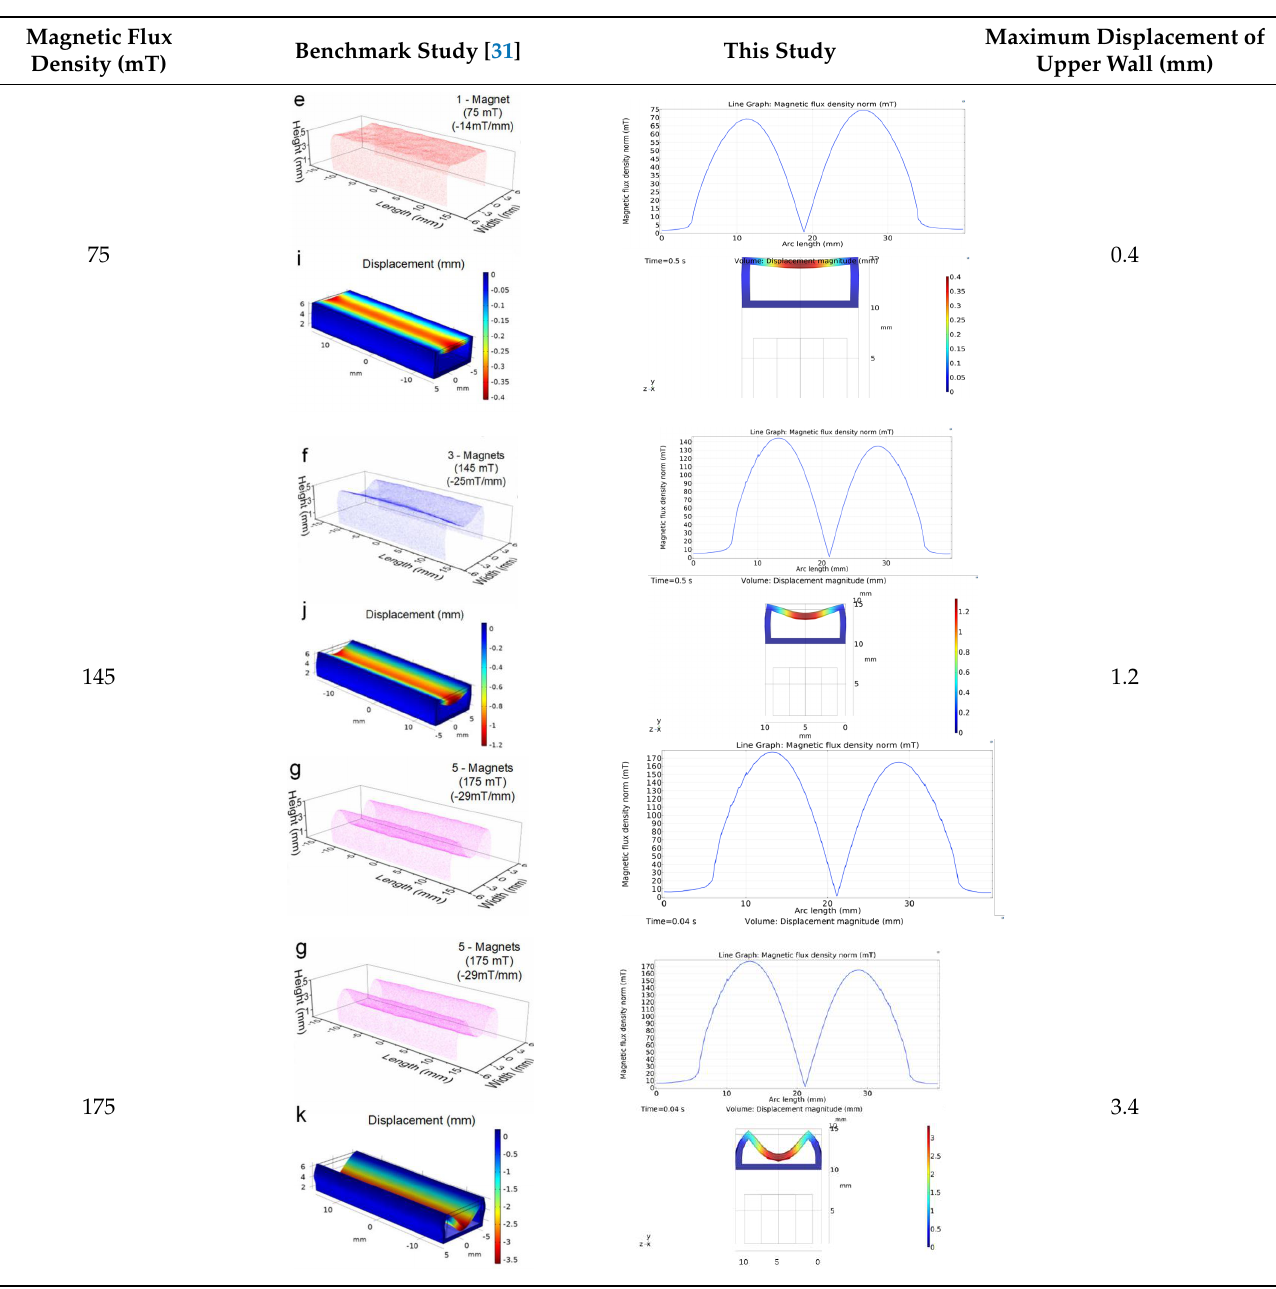
Figure 8. Net pumped volume comparisons between this study and benchmark study [31]. Table 4. Percent error of the flow rates between this study and benchmark study [31]. Magnetic Flux Density (mT)